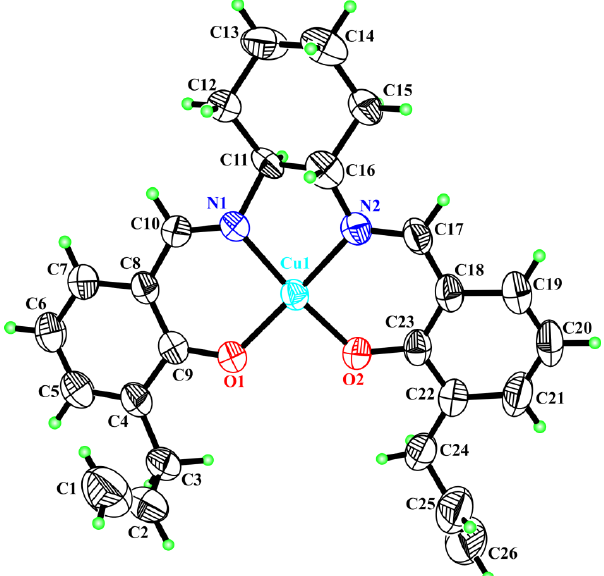
Figure 3. The X-ray structure for complex 3 with thermal displacement ellipsoids drawn at the 50% probability level (disordered atoms omi tt ed for clarity).